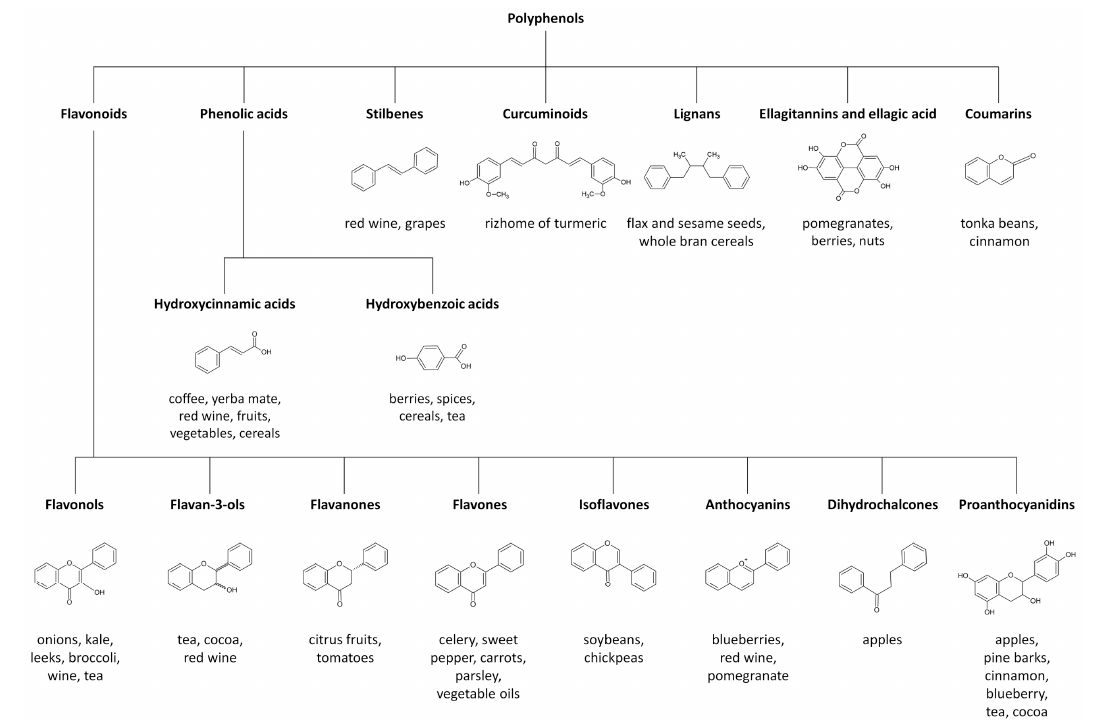
Figure 1. Major polyphenol classes and their most important food sources.